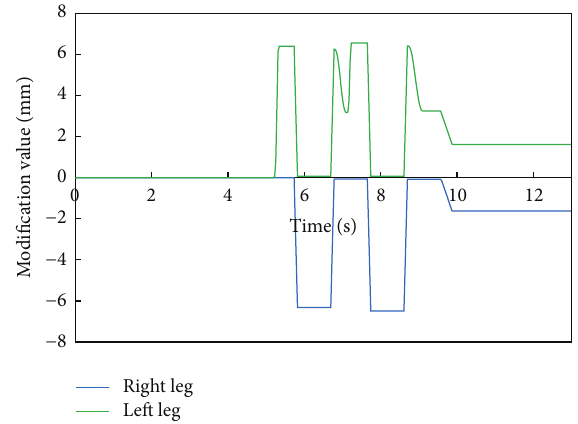
Figure 16: Modification value of a swing foot along the lateral axis with the human-like foot